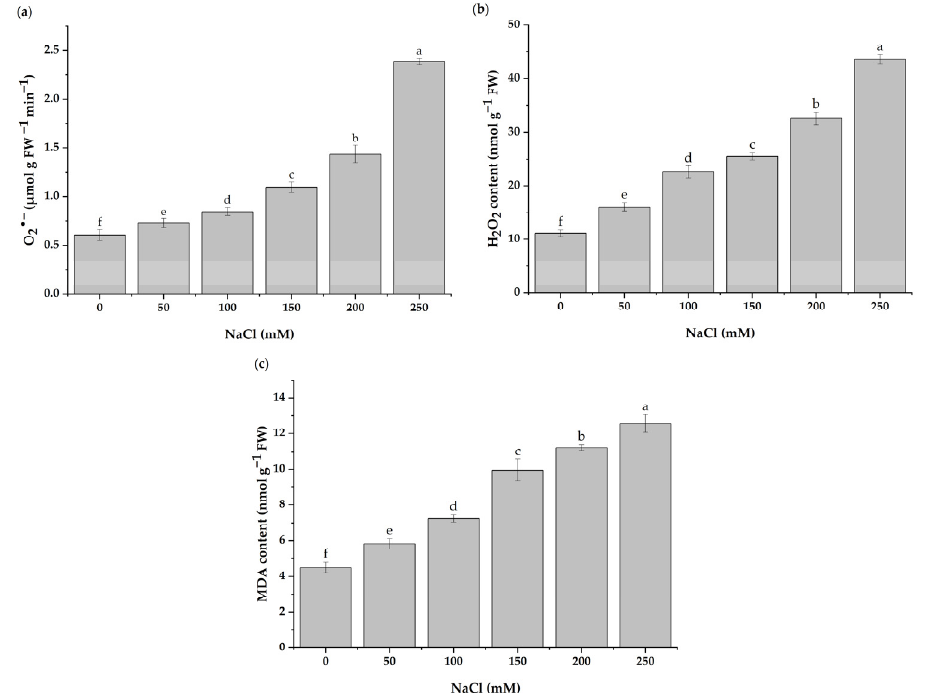
Figure 4. O 2 •− contents ( a ), H 2 O 2 contents ( b ), and MDA contents ( c ) in leaves of H. cannabinus under various salt stress levels (0, 50, 100, 150, 200, and 250 mM of NaCl). The values presented are means ± SD ( n = 3). Different letters (a–f) above the bars indicate a significant difference between treatments according to the Duncan test ( p < 0.05).